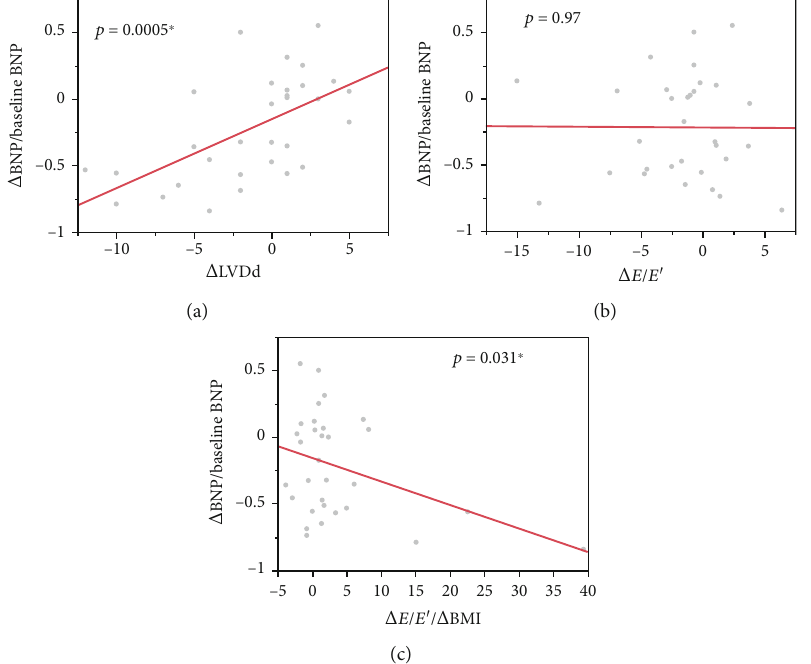
Figure 5: Relationship between relative changes in BNP and changes in LVDd, E / E ′ , and E / E ′ adjusted by BMI. Relationship between relative changes in BNP and the changes in (a) LVDd, (b) E / E ′ , and (c) E / E ′ divided by BMI in study subjects from baseline to 26 weeks